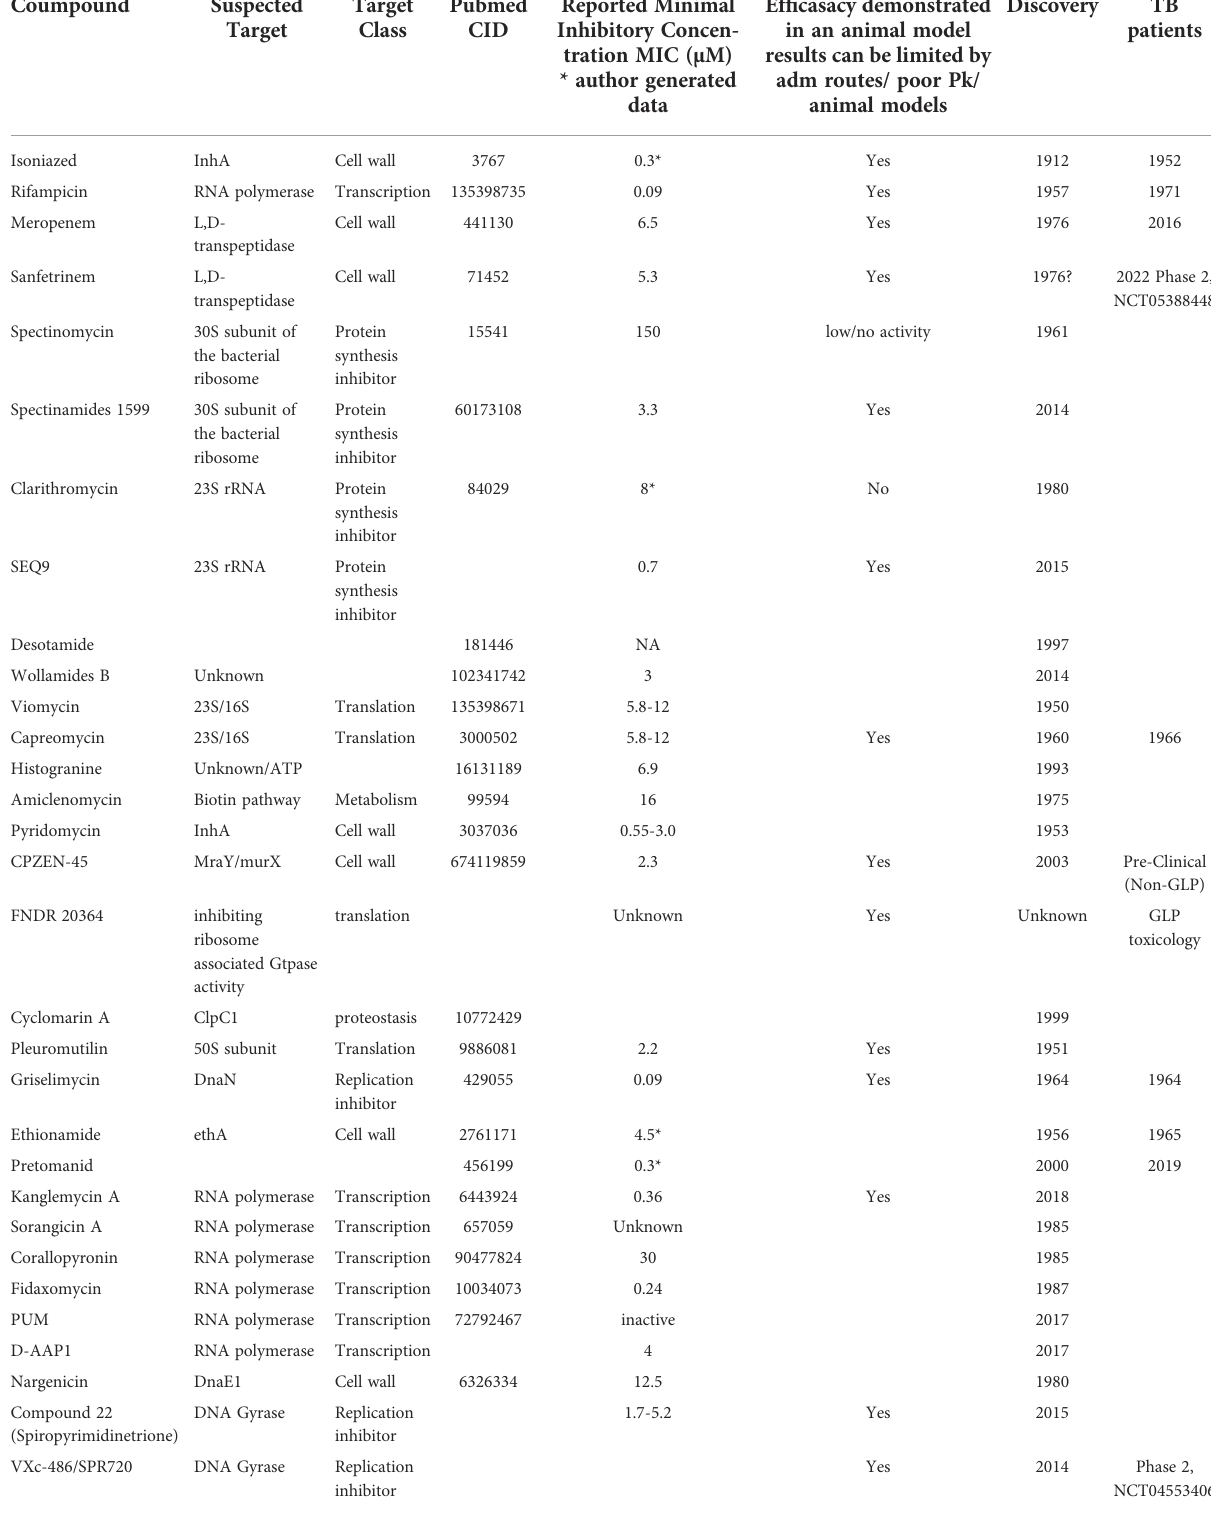
TABLE 1 Compounds described in this